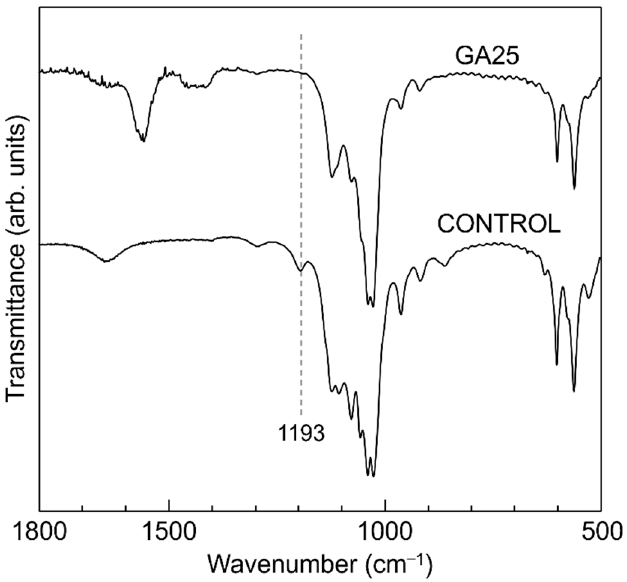
Figure 4. FTIR spectra of plain OCP (control) and the OCP sample synthesised using 25 mmol of glutaric acid (GA25).